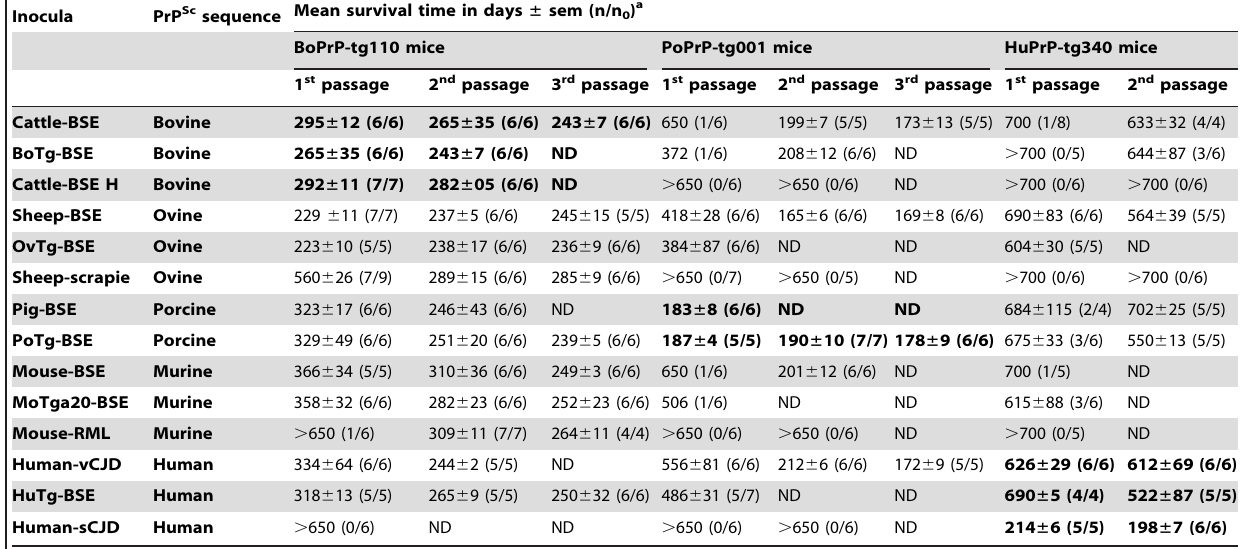
a Intracerebral inoculation with 2 mg brain tissue equivalent; n/n ND: not